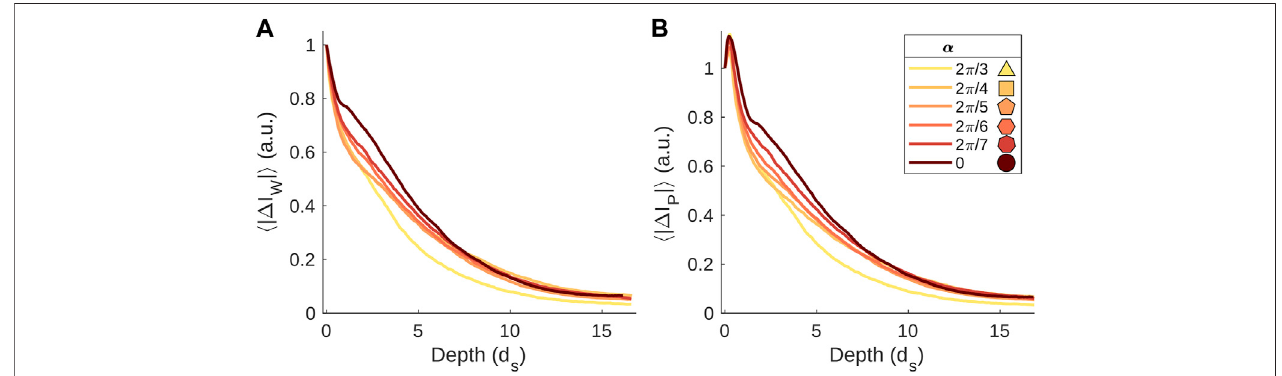
FIGURE 13 | (A) Average intensity of 〈 | Δ I W | 〉 with depth, rescaled by the intensity at a depth of 0 d s , for each grain angularity. (B) Average intensity of 〈 | Δ I P | 〉 with depth, rescaled by the intensity at a depth of 0 d s , for each grain